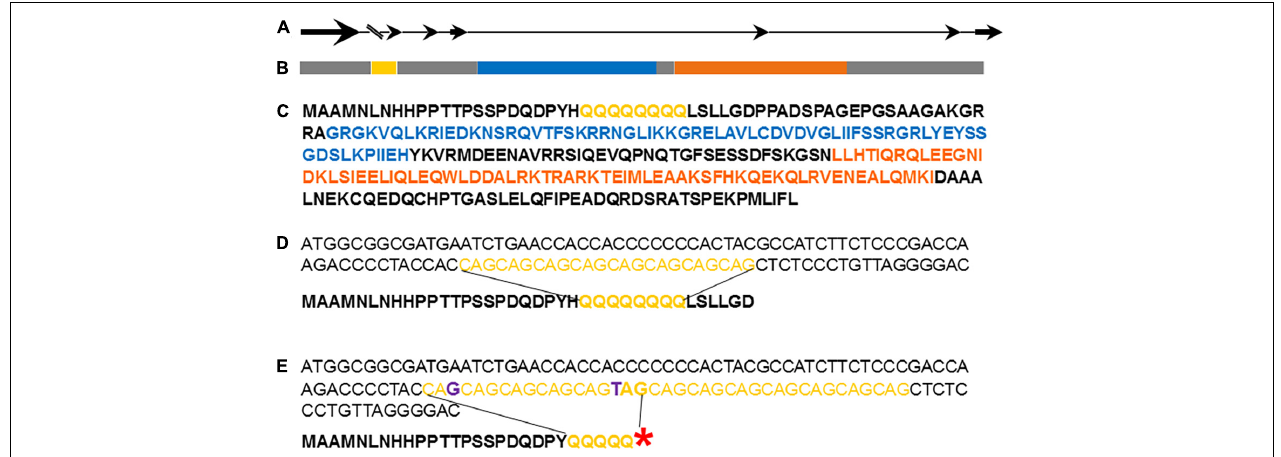
FIGURE 6 | Graphic illustration of pomegranate PgPolyQ-MADS structure. Genomic composition of the gene (A) . Bold arrows represent axons, thin lines represent introns, and parallel lines represent first intron composed of ∼ 8,000 bp. LOC116195279 (B) , XP_031380211.1 isoform X1 protein sequence (C) and the polymorphism between P.G.100-1 (D) and P.G.160-61 (E) at the DNA and predicted amino acid sequences. Red asterisk represent stop codon caused by replacement of C by T. Yellow represents CAG repeats or poly glutamine, blue represents the MADS_MEF2_like conserved sequence, orange the K-box consensus sequence, and purple are the nucleotides changes between P.G.100-1 and P.G.160-61.